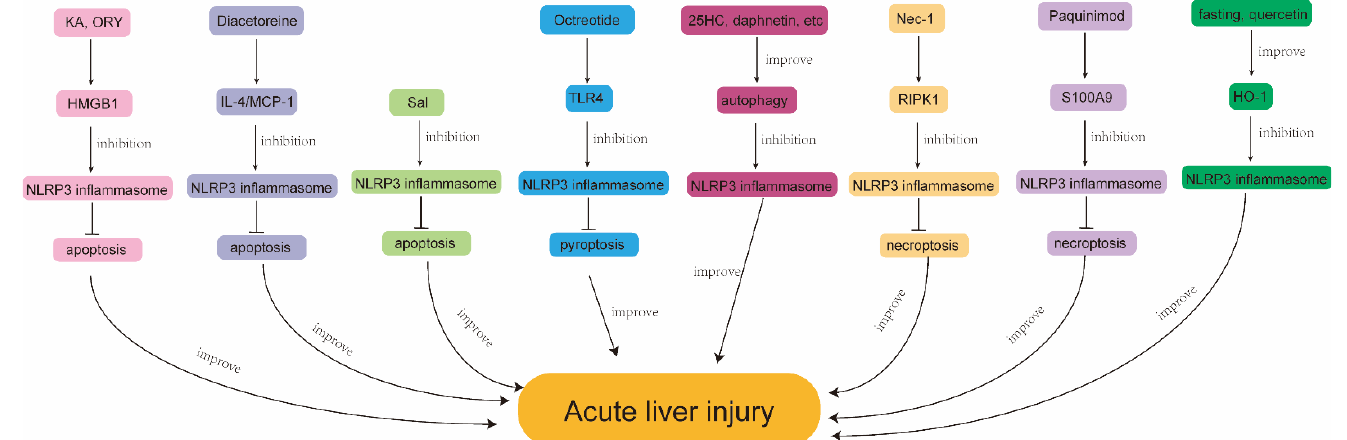
Figure 3. Mechanisms exerting protective effects by regulating NLRP3 inflammasome and PCD in ALI. KA, kaempferol; ORY, γ -Oryzanol; HMGB1, high mobility group protein B1; NLRP3,